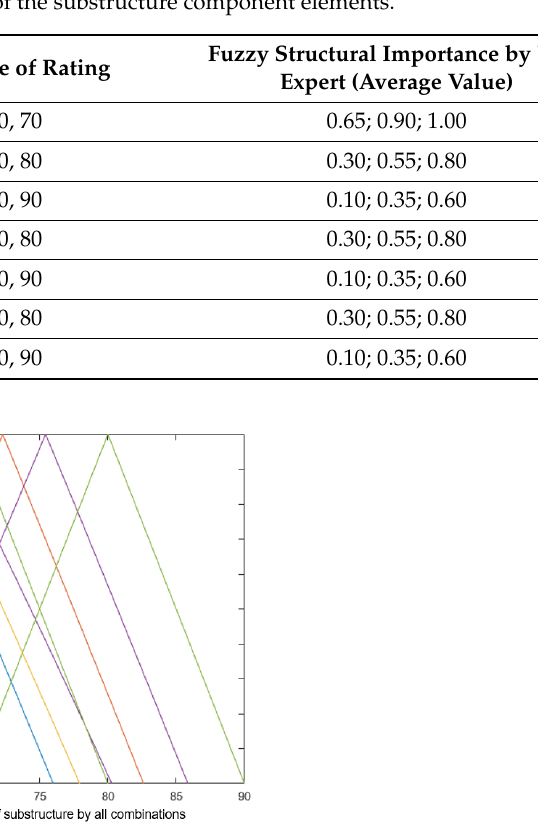
Figure 8. Graphical representation of the substructure component rating values for all combinations. Table 11. The average of all combinations—the final fuzzy value of the substructure component rating.